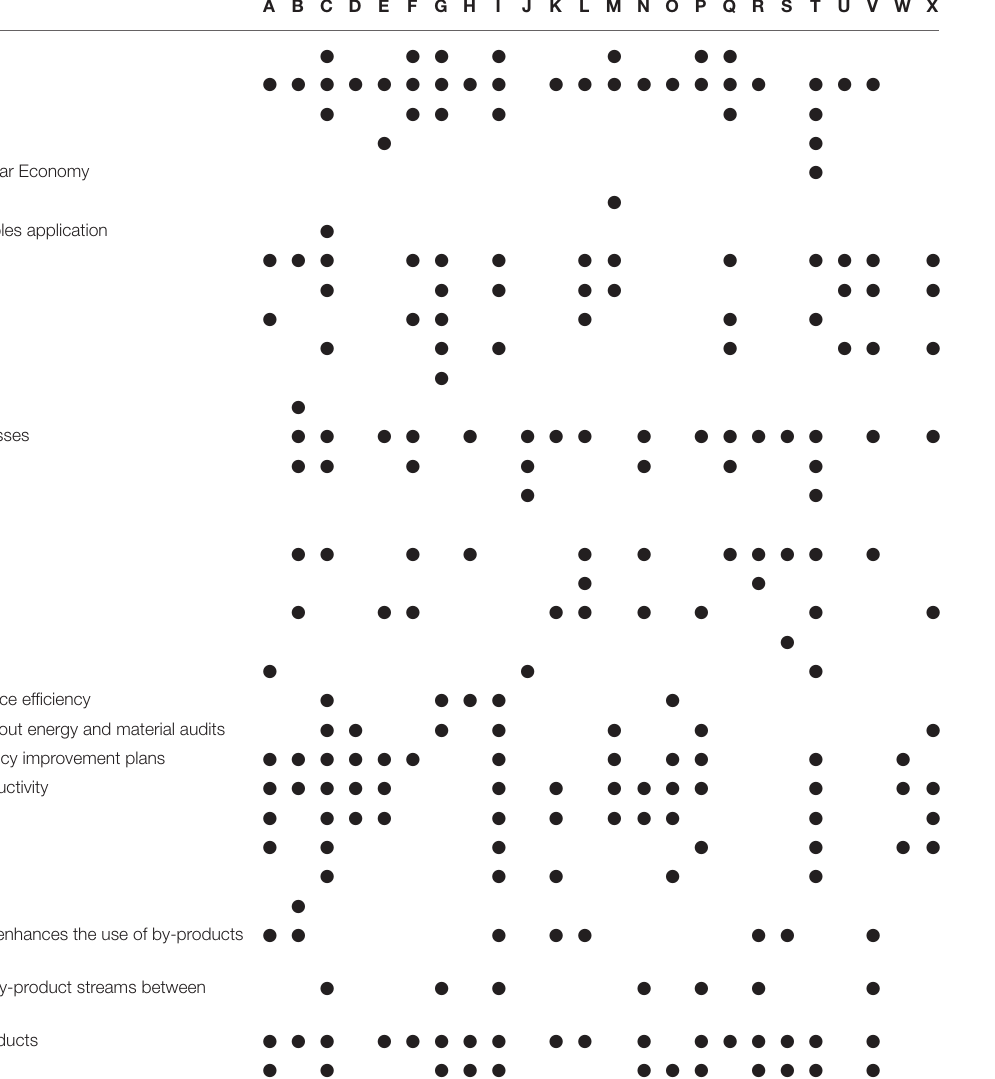
TABLE 1 | Identification of competences in Circular Economy of each of the